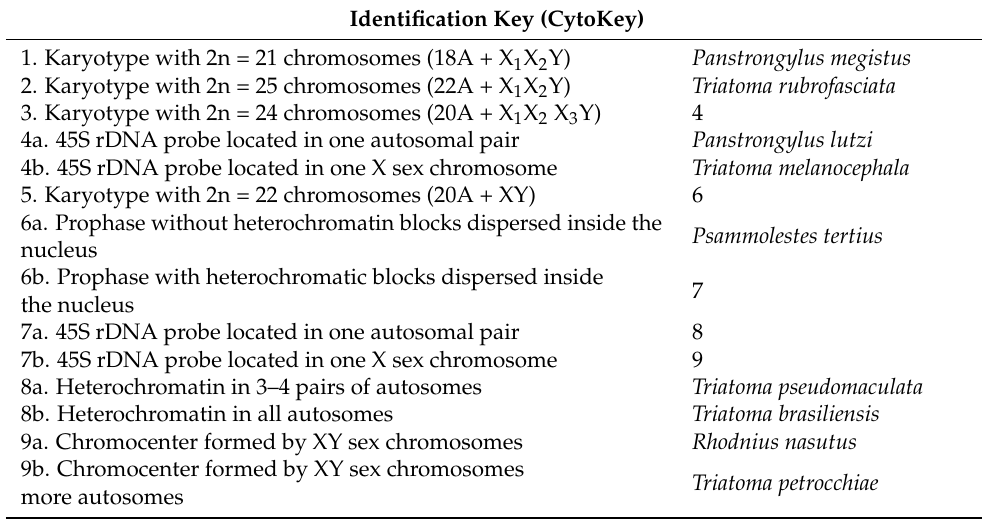
Table 2. Dichotomous key for species from Rio Grande do Norte, based on cytogenetic data. Identification Key